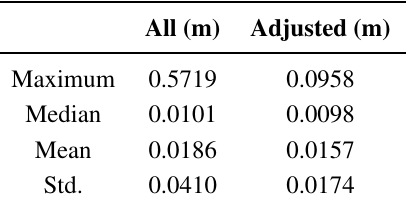
Table 3. Quadratic deviation of control points; Case 4.